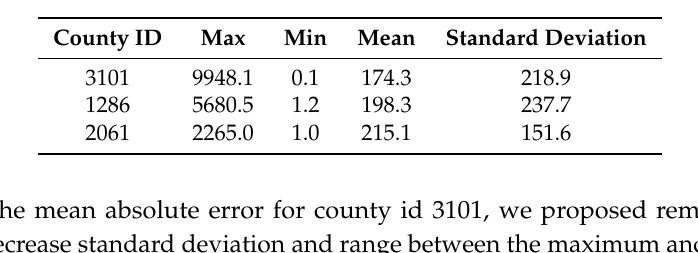
Figure 8. Data Distribution. Table 5. Price Distribution by County in One Thousand